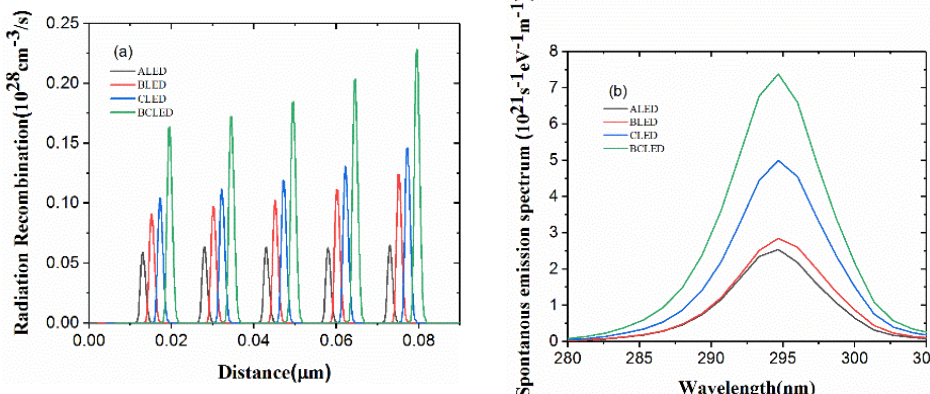
Figure 6. ( a ) Spontaneous emission spectrum and ( b ) radiative recombination rates at 400